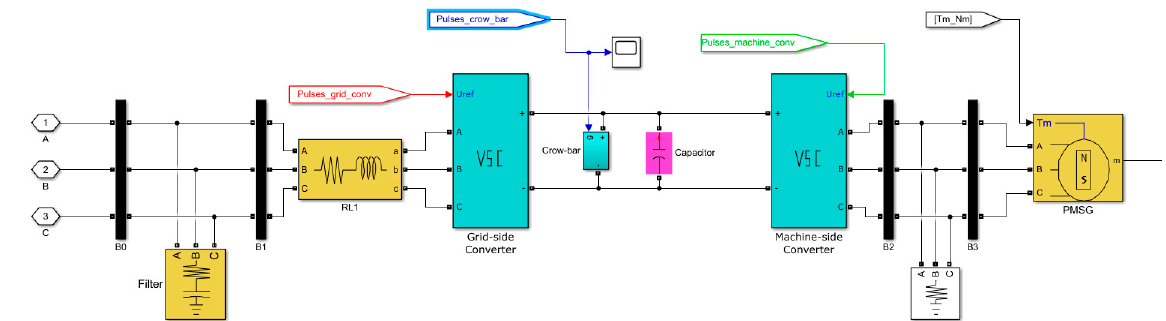
Figure 2. Detailed section of the wind turbine generator consisting of a PMSG and a full B2B converter.